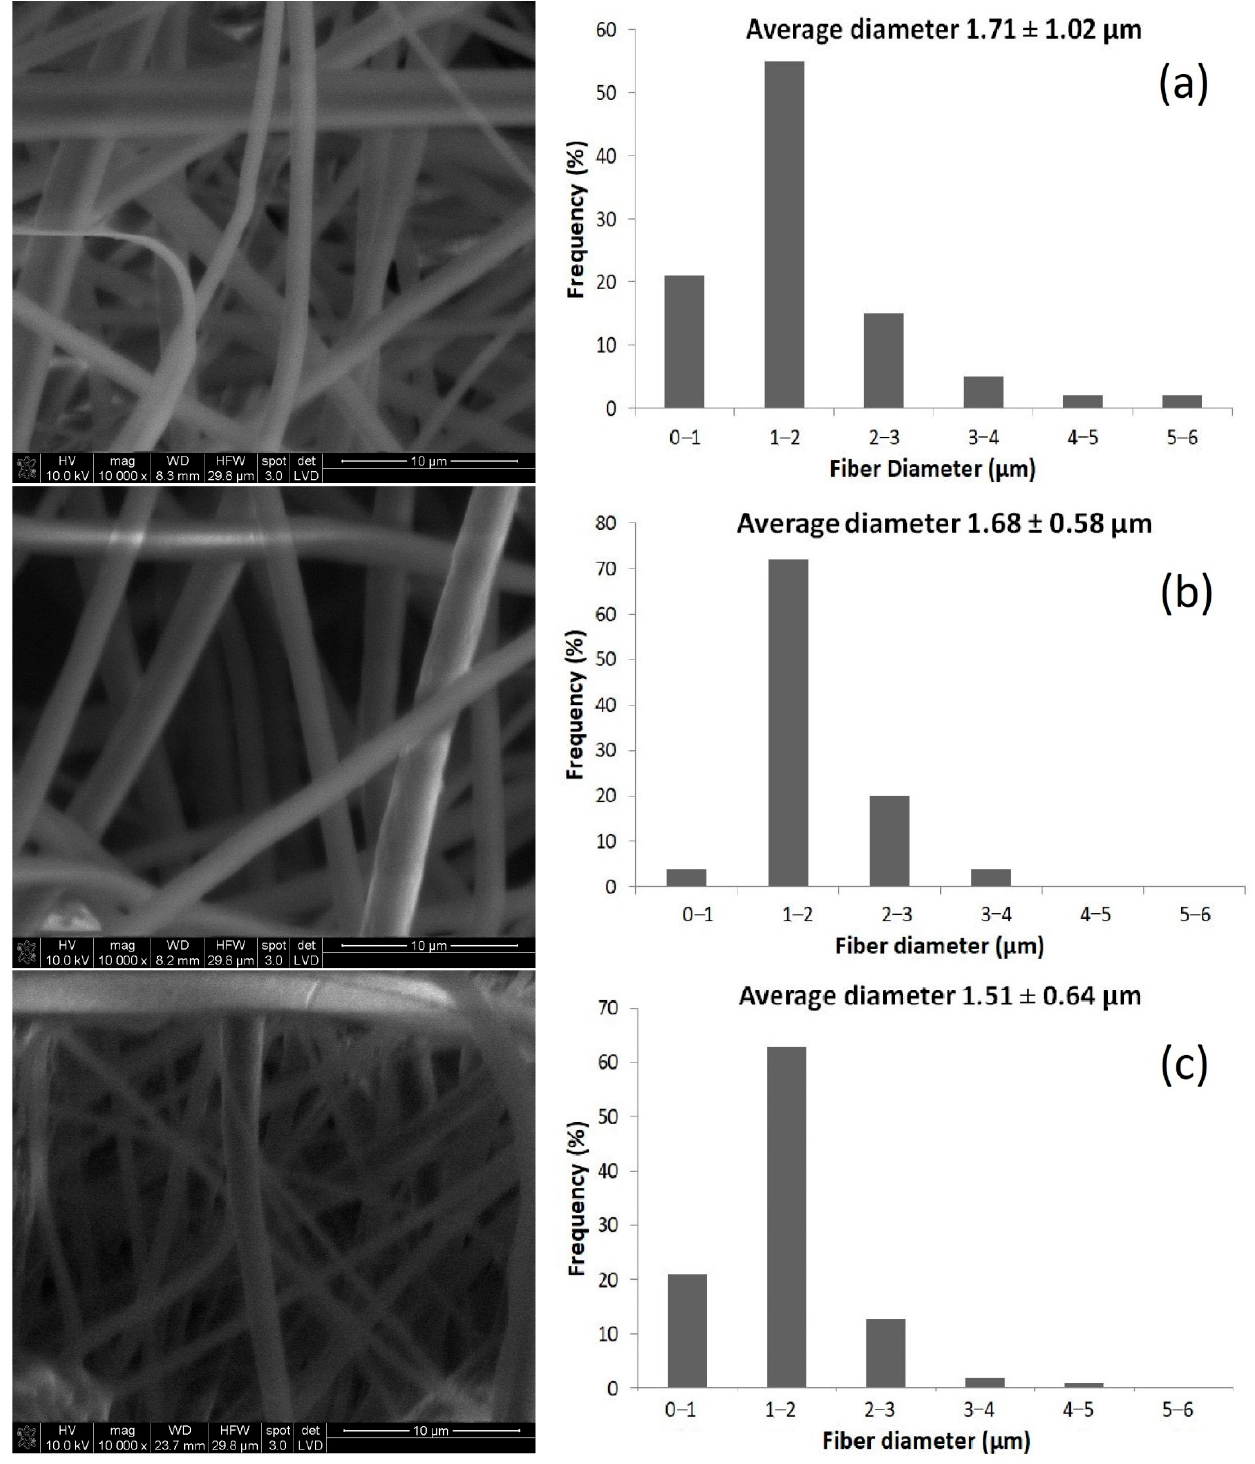
Figure 1. SEM images and fiber diameter distributions of the electrospun nonwoven fabrics obtained from ( a ) PLA, ( b ) 3HPO/PLA and ( c ) 5HPO/PLA ( × 10,000) (average ± standard deviation).